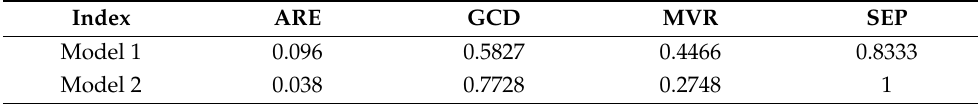
Table 4. Precision index of Models 1 and 2 in 2006